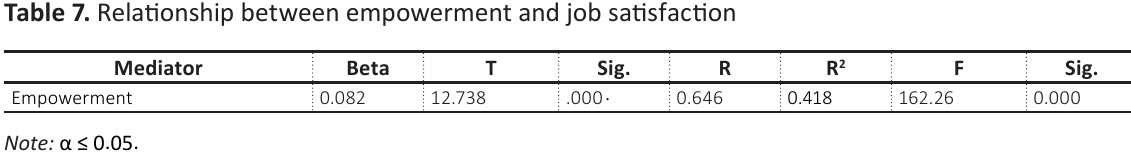
Table 8. Relationship between empowerment and fairness of pay and